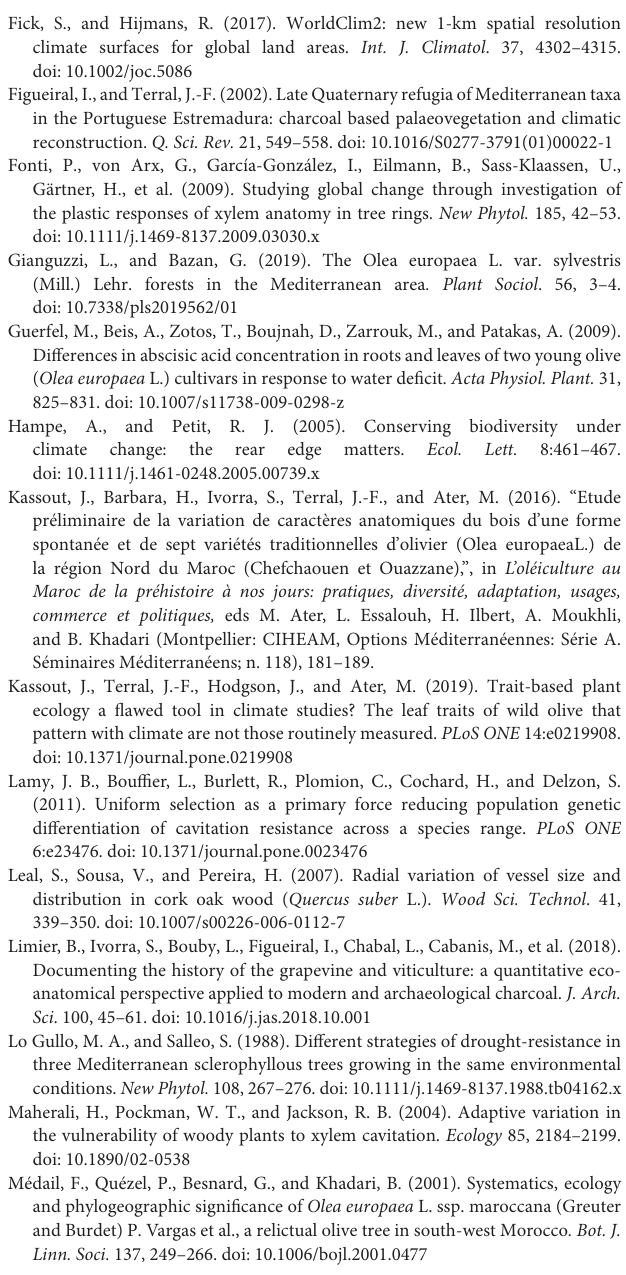
Supplementary Table 7 | Pair-wise comparisons provided of differences in Standardized Major Axis regression slopes for the regression between vessel surface area (SVS) and branch diameter (BD) of the studied samples grouped according to their climatic context. Supplementary Table 8 | Pair-wise comparisons provided of differences in Standardized Major Axis regression slopes and elevation for the regression between vessel surface area (SVS) and branch diameter for the studied samples grouped into seven groups according to their climatic and vegetation